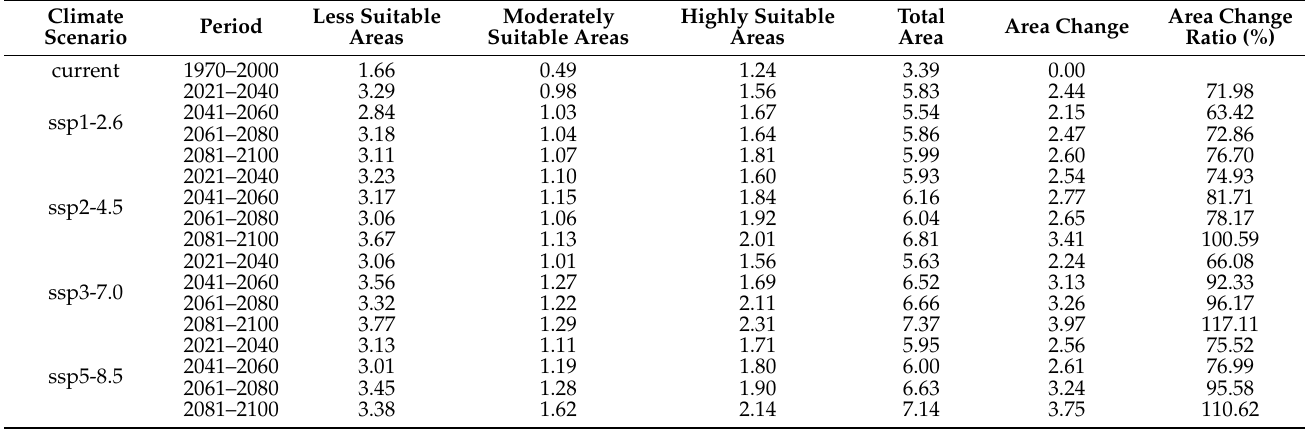
Figure 9. The potential distribution of suitable areas for A. americanum around the world under the climatic conditions of shared socio-economic pathway 5-8.5 (fossil-fueled development and radiative forcing of 8.5 W/m 2 to 2100) during different periods of the 21st century: ( a ) 2021–2040, ( b ) 2041–2060, ( c ) 2061–2080, ( d ) 2081–2100. Table 2. Current and future suitable area for Amblyomma americanum across the world under different climatic conditions ( × 10 6 km 2 ).